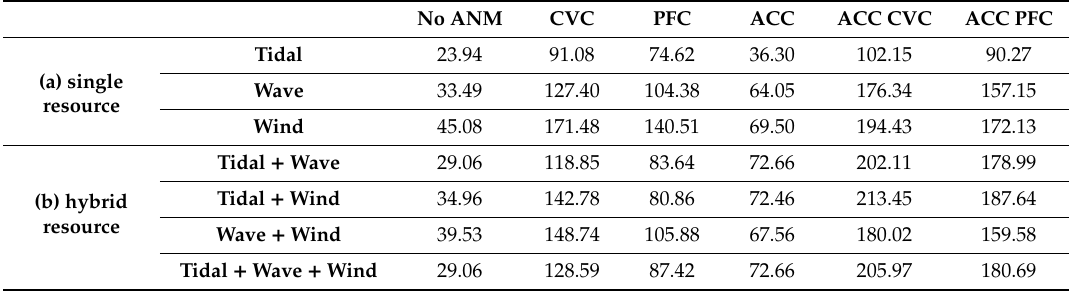
Table 6. Energy delivered (GWh / year) from di ff erent resource cases for a range of control configurations.